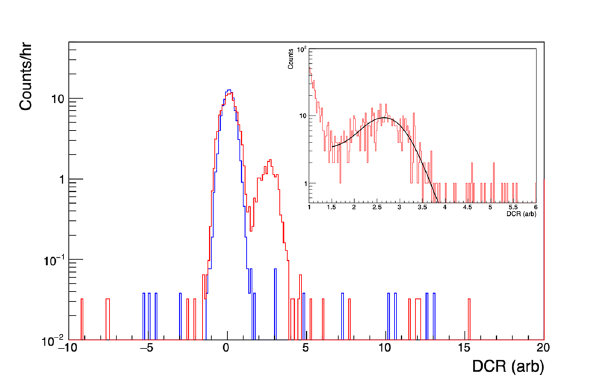
Fig. 16 DCR parameter distributions and α peak fits. The peaks are fit with the sum of a Gaussian curve and a step function accounting for the tail of the bulk event distribution (in black, see